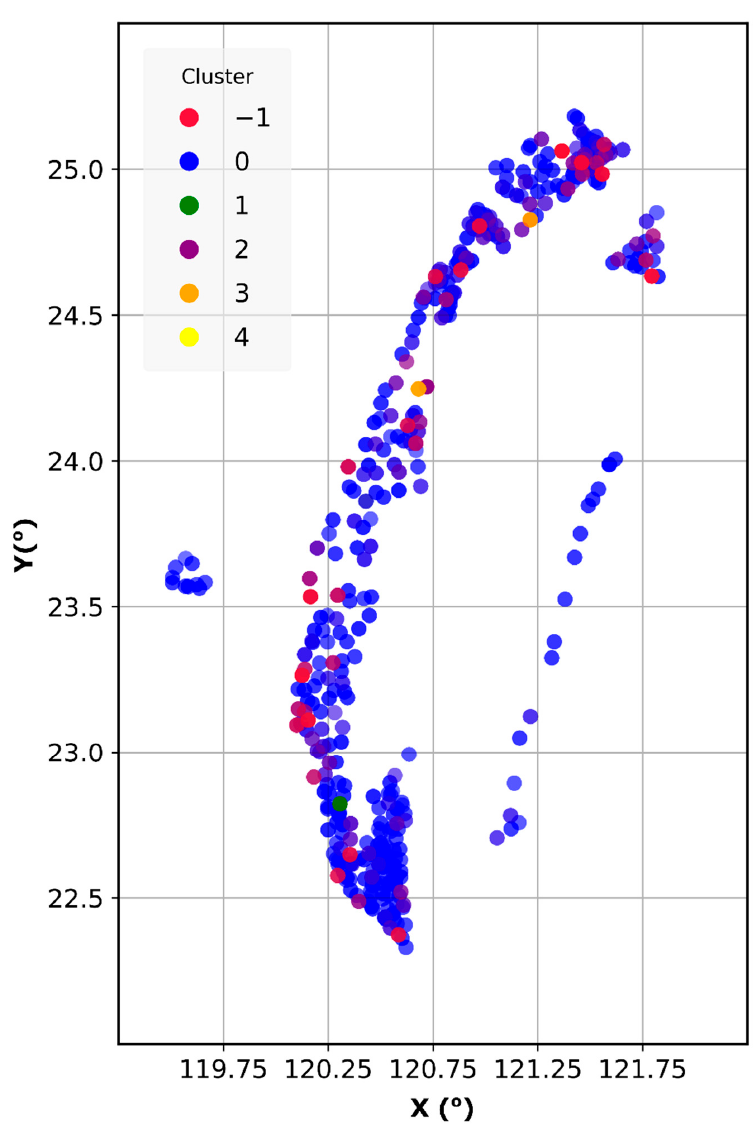
Figure 3. Scatter plot showing the spatial distribution of derived clusters and outliers.